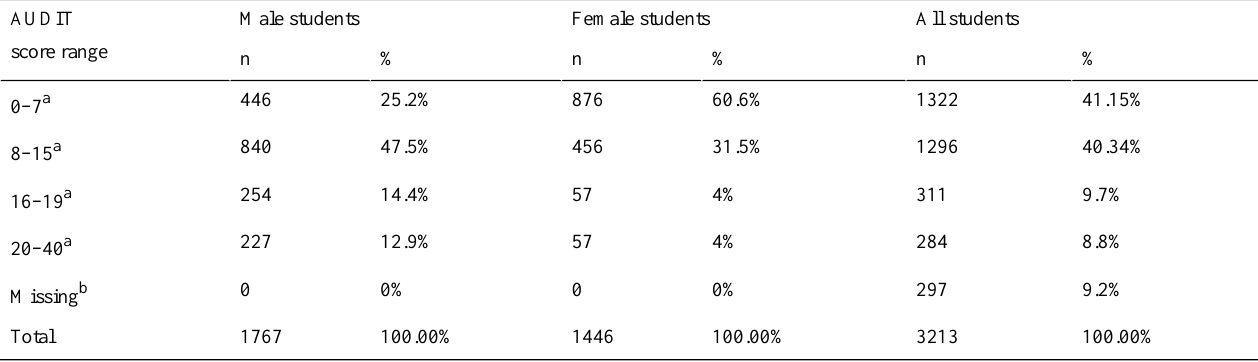
Table 2. Alcohol Use Disorders Identification Test (AUDIT) score versus gender.